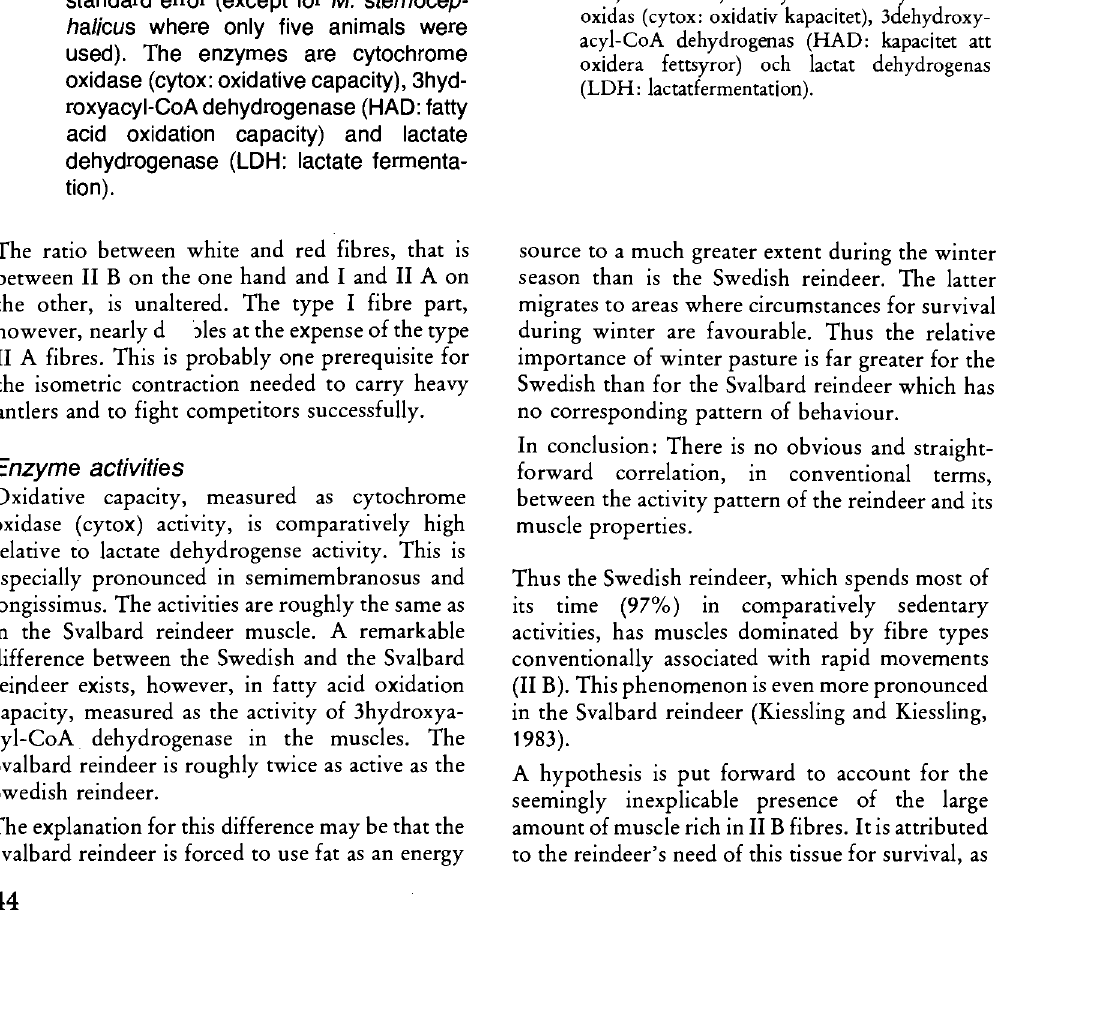
Fig. 2. Enzymaktivitet i sex skelettmuskler från svensk tamren. Staplarna år medelvården av 12 - 15 djur (med undantag av M. sternocephalicus dår endast 5 djur anvånts). Enzymerna år cytochrome oxidas (cytox: oxidativ kapacitet), 3dehydroxy- acyl-CoA dehydrogenas (HAD: kapacitet att oxidera fettsyror) och lactat dehydrogenas (LDH: